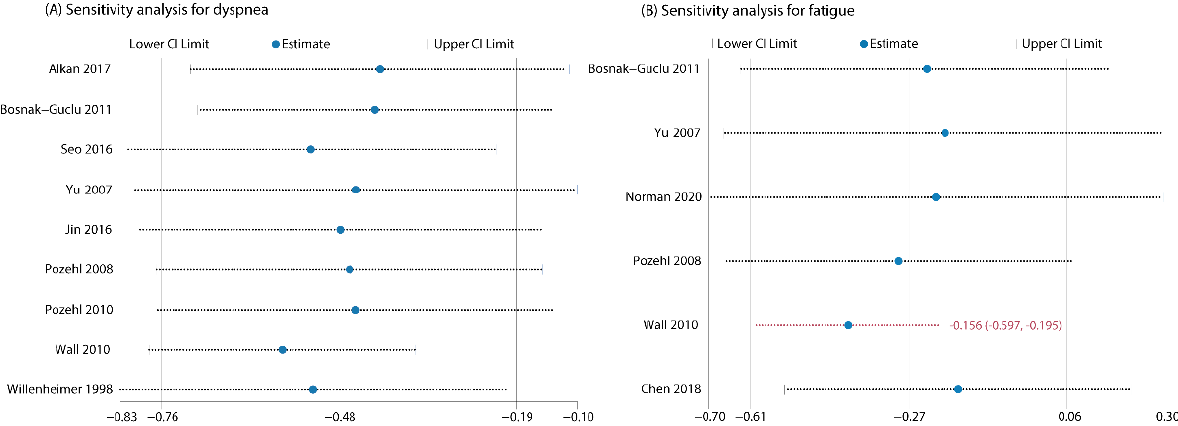
Figure 4. ( A ) Sensitivity analysis for dyspnea by omitting one study in turn (did not change the results of primary meta-analysis); ( B ) Sensitivity analysis for fatigue by omitting one study in turn (changed the results of primary meta-analysis after removing Wall 2010).